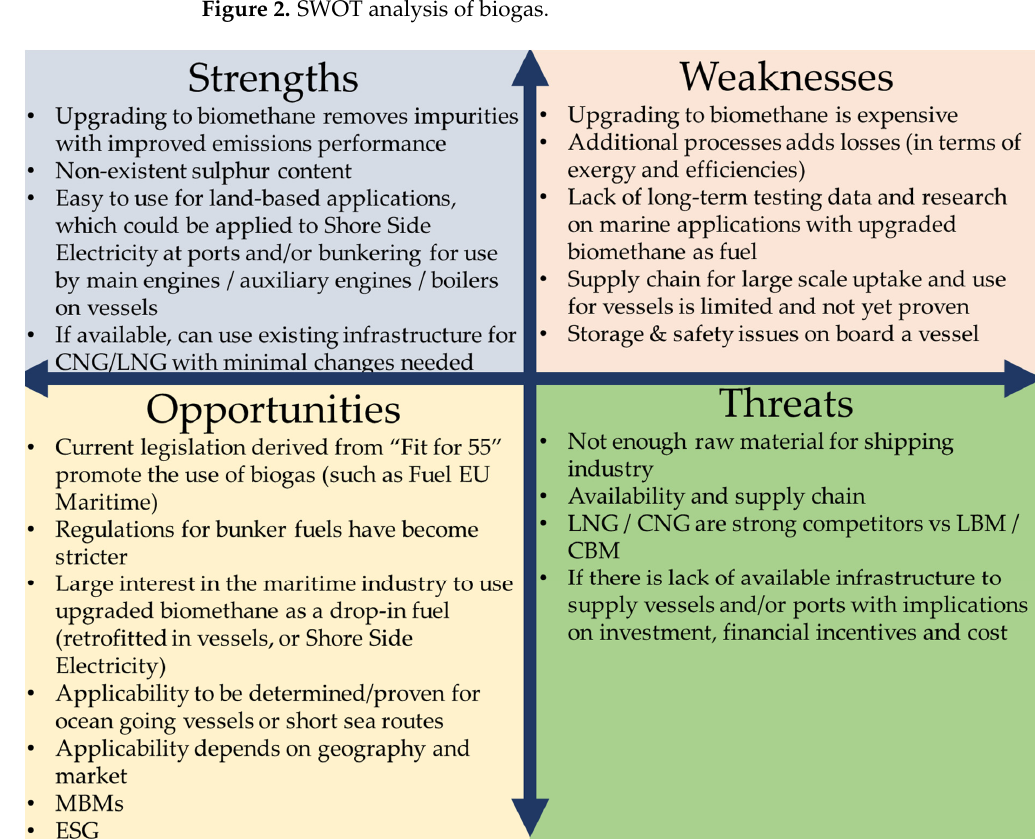
Figure 3. SWOT analysis of biomethane.